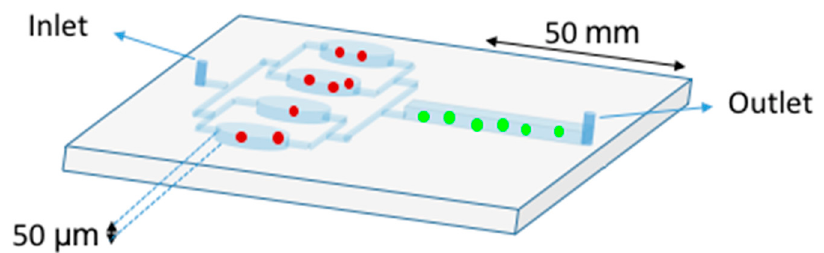
Figure 6. Double Stage Cascade Device used for CD4 counting. The PDMS device harbors two distinct functions: monocyte depletion (upstream) and CD4 + T cell capture (downstream). The upstream region contains four parallel chambers (50 µ m height) coated with an anti-CD14 antibody in order to specifically retain the monocytes (red spots). The monocyte depletion increases the sensitivity and specificity of CD4 + T cell (green spots) retention in the main channel (downstream), which was functionalized with an anti-CD4 antibody. After sample injection, rinsing steps are crucial to avoid shearing off captured cells [57].